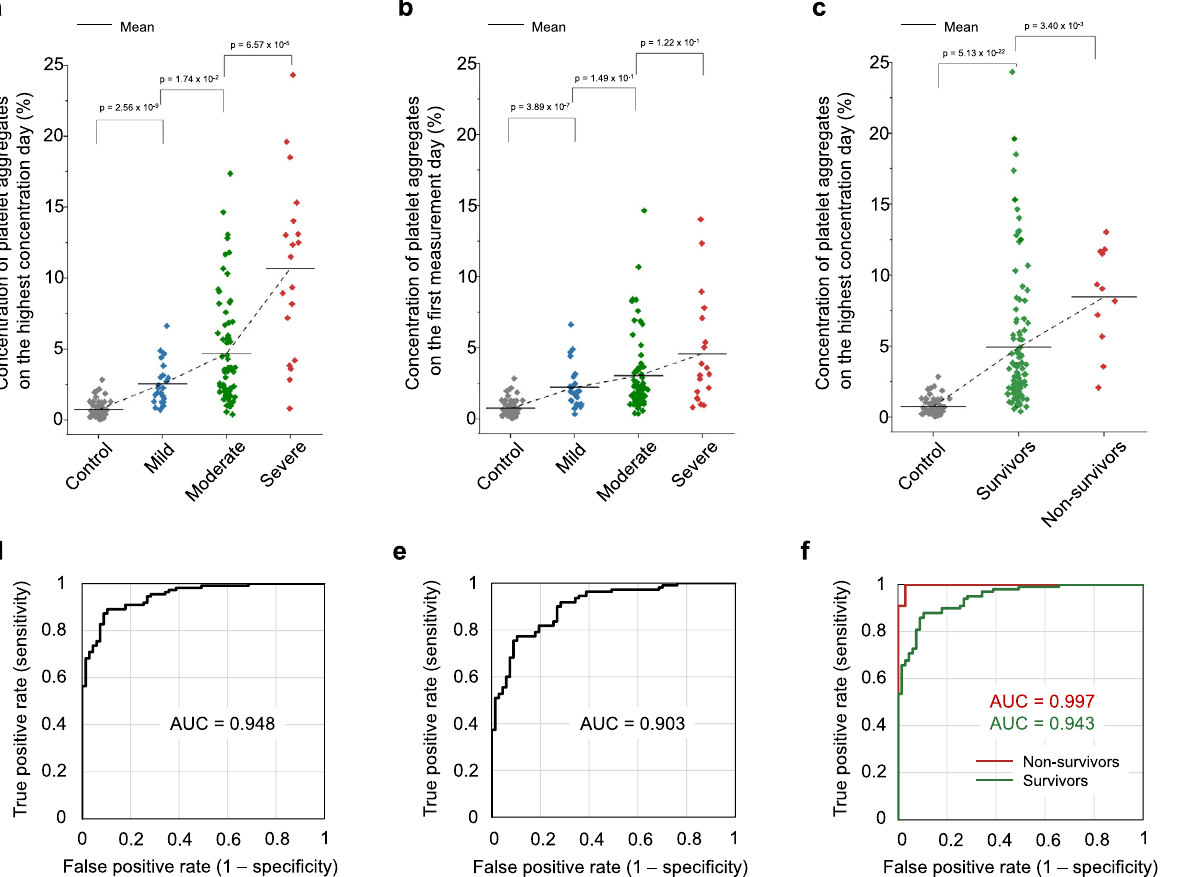
Fig. 3 Comparison with the severity and mortality of COVID-19. P values of every two adjacent classes were obtained using the Mann – Whitney U -test (two-sided) and shown in the fi gure. a Comparison of the platelet aggregate concentrations of mild ( n = 23 biologically independent samples), moderate ( n = 68 biologically independent samples), and severe ( n = 19 biologically independent samples) patients with COVID-19, measured on the highest concentration day of each hospitalized patient. p = 7.41 ×10 -24 with the two-sided Kruskal – Wallis test. For the de fi nition of images containing platelet aggregates, see “ statistical analysis ” in the Methods section for details. b Comparison of the platelet aggregate concentrations of mild ( n = 23 biologically independent samples), moderate ( n = 68 biologically independent samples), and severe ( n = 19 biologically independent samples) patients with COVID-19 on the fi rst measurement day of each hospitalized patient. p = 4.37 ×10 -18 with the two-sided Kruskal – Wallis test. c Comparison of the platelet aggregate concentrations of survivors ( n = 99 biologically independent samples) and non-survivors ( n = 11 biologically independent samples) from COVID-19, measured on the highest concentration day of each hospitalized patient. p = 3.05 ×10 -23 with the two-sided Kruskal – Wallis test. d , e , f , ROC curves of the data shown in Figs. 3a – c, respectively. Source data are provided as a Source Data fi